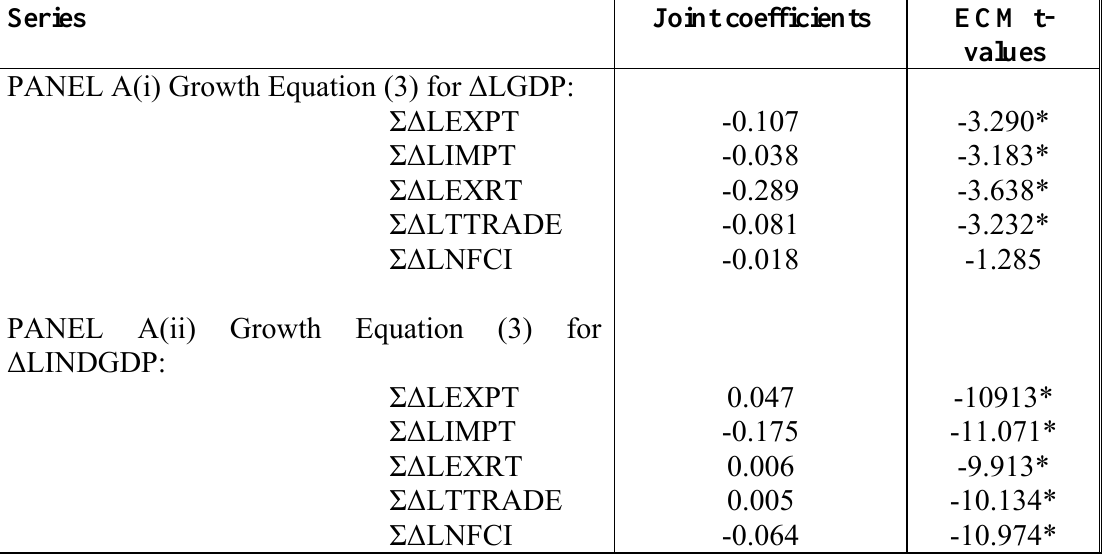
F-statistics for the bivariate causality test based on VECM